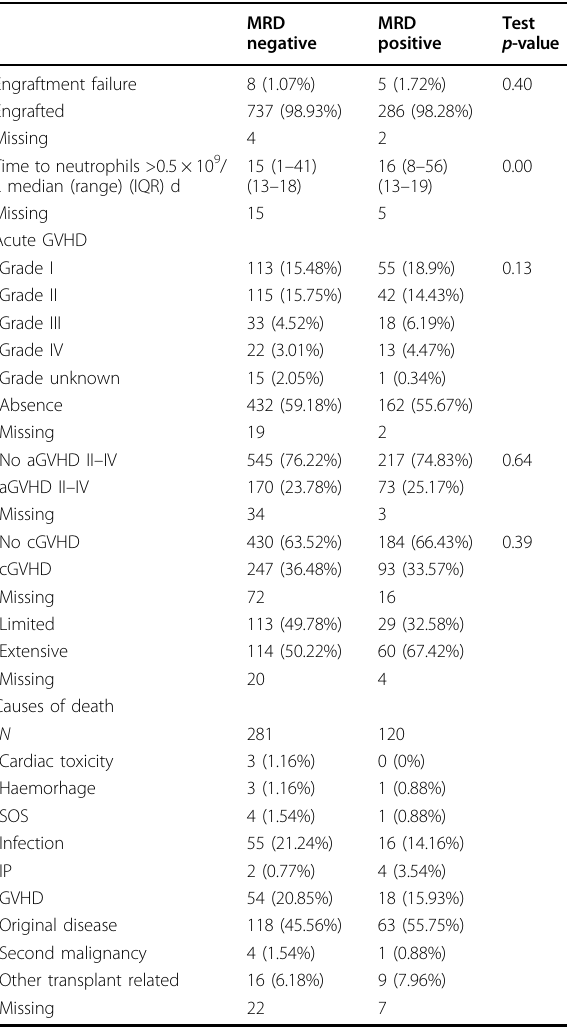
Table 3. MRD Negative status conferred a signi fi cantly